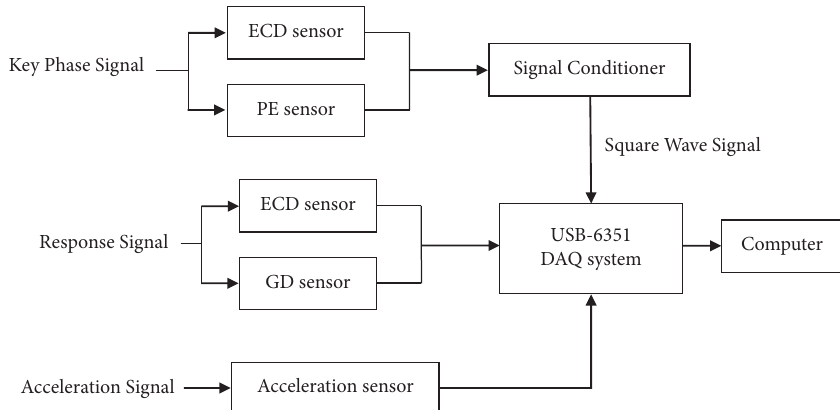
Figure 3: The hardware design of the dynamic-balancing testing system.